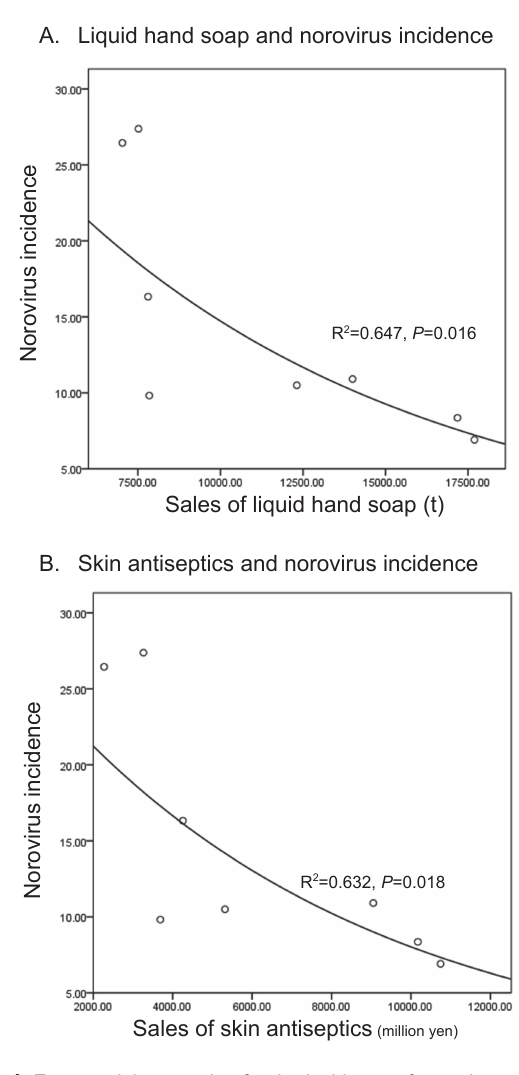
Fig. 4 Exponential regression for the incidence of norovirus and sales of hand hygiene products. Sales and incidence data were fi tted to exponential regression models for A) liquid hand soap and B) skin antiseptics for the epi- demic period of COVID-19 (2020 – 2021 and 2021 – 2022 seasons combined). Because the epidemic starts in September, the data in September were excluded in the regression